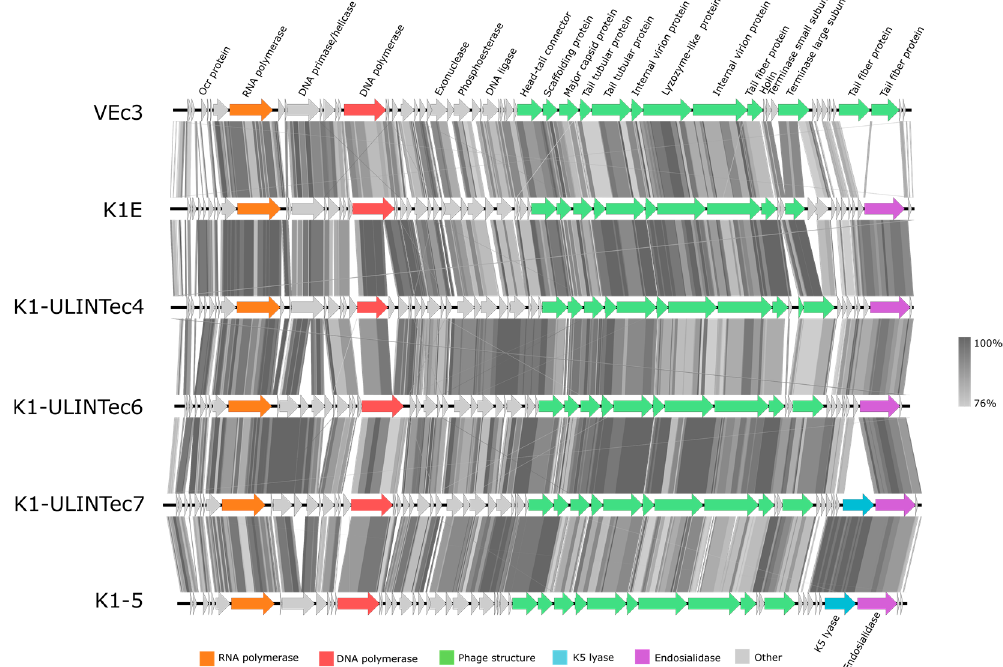
Figure 6. Comparative genomics of phages vB_EcoP_K1-ULINTec4 (K1-ULINTec4), vB_EcoP_K1-ULINTec6 (K1-ULINTec6), vB_EcoP_K1-ULINTec7 (K1-ULINTec7), and VEc3, K1E and K1-5.